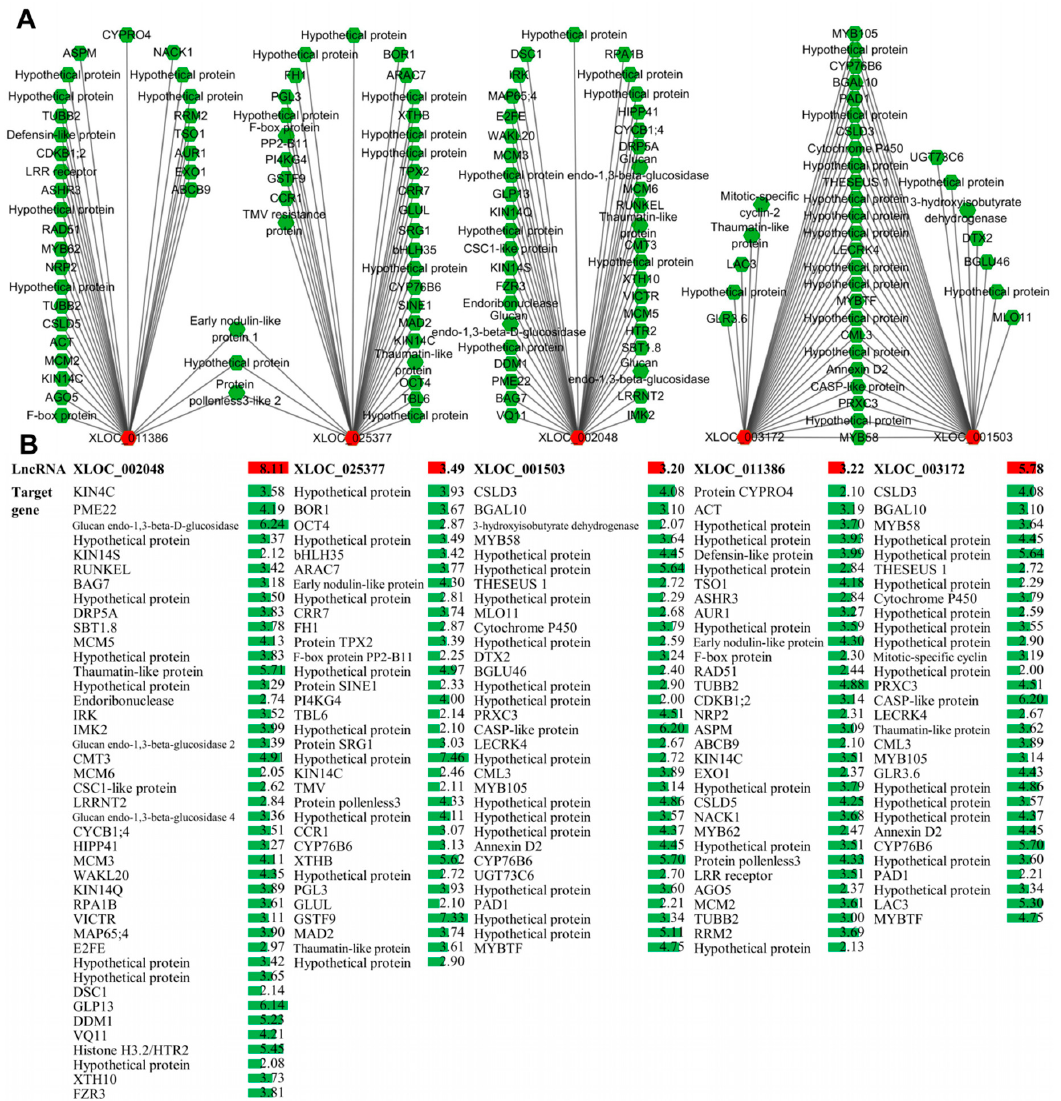
Figure 9. The top five lncRNAs of the interaction network among lncRNAs and target protein-coding genes. ( A ) Co-expression network. The nodes represent lncRNAs and protein-coding genes and edges show regulatory interactions among nodes. ( B ) Data bars with di ff erent colors show the expression levels of lncRNAs (colored in red) and target protein-coding genes (colored in green) under boron deficiency conditions.